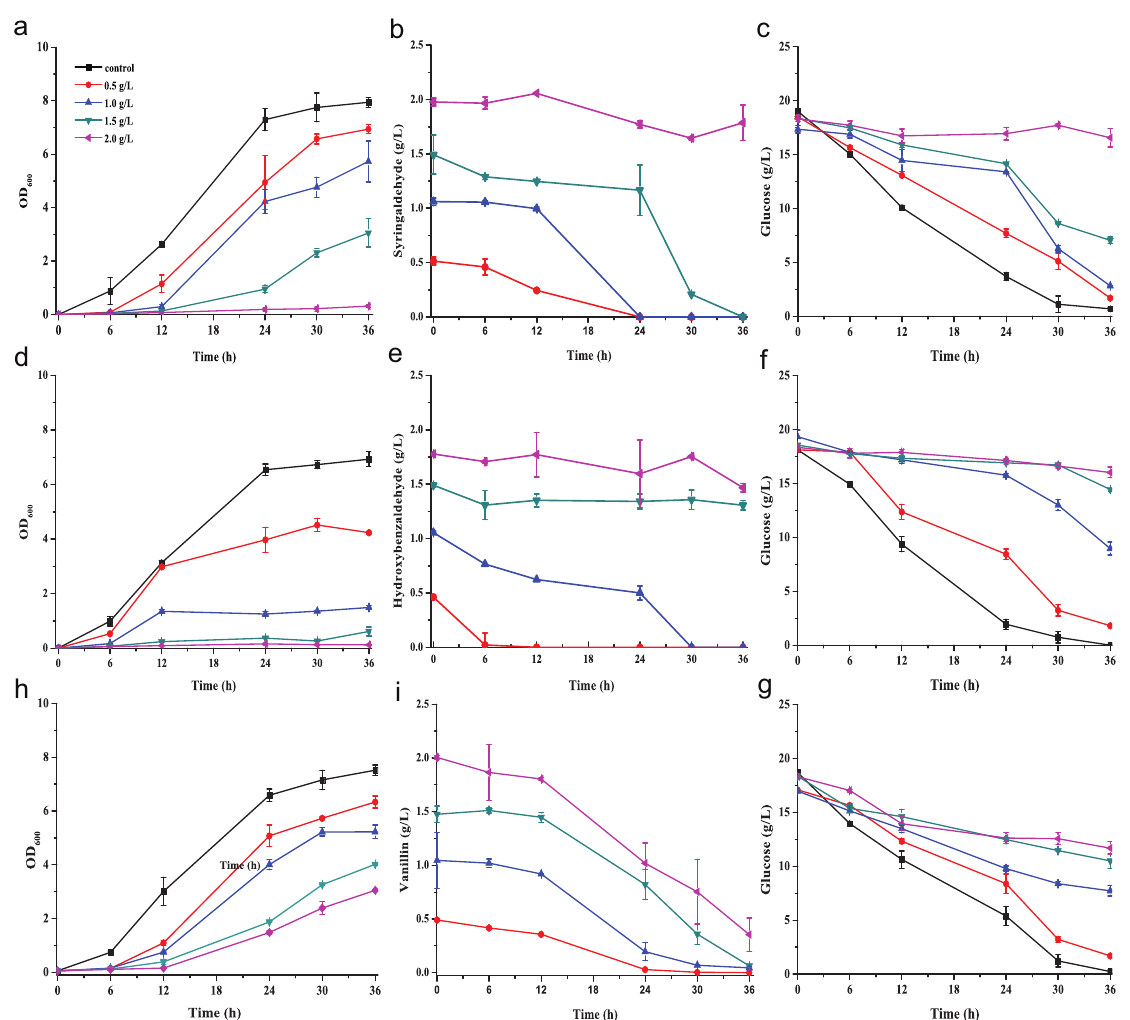
Figure 1. Degradation of phenolic inhibitors by K. huakuii LAM0618 T in a rich medium. Growth curve of K. huakuii LAM0618 T , inhibitor degradation curve and glucose consumption curve in a rich medium containing syringaldehyde ( a – c ), hydroxybenzaldehyde ( d – f ), and vanillin ( h – g ) at 0.5, 1.0, 1.5, or 2.0 g/L, respectively. All experiments were performed in duplicate and results are presented as mean ± SD. Error bars indicate